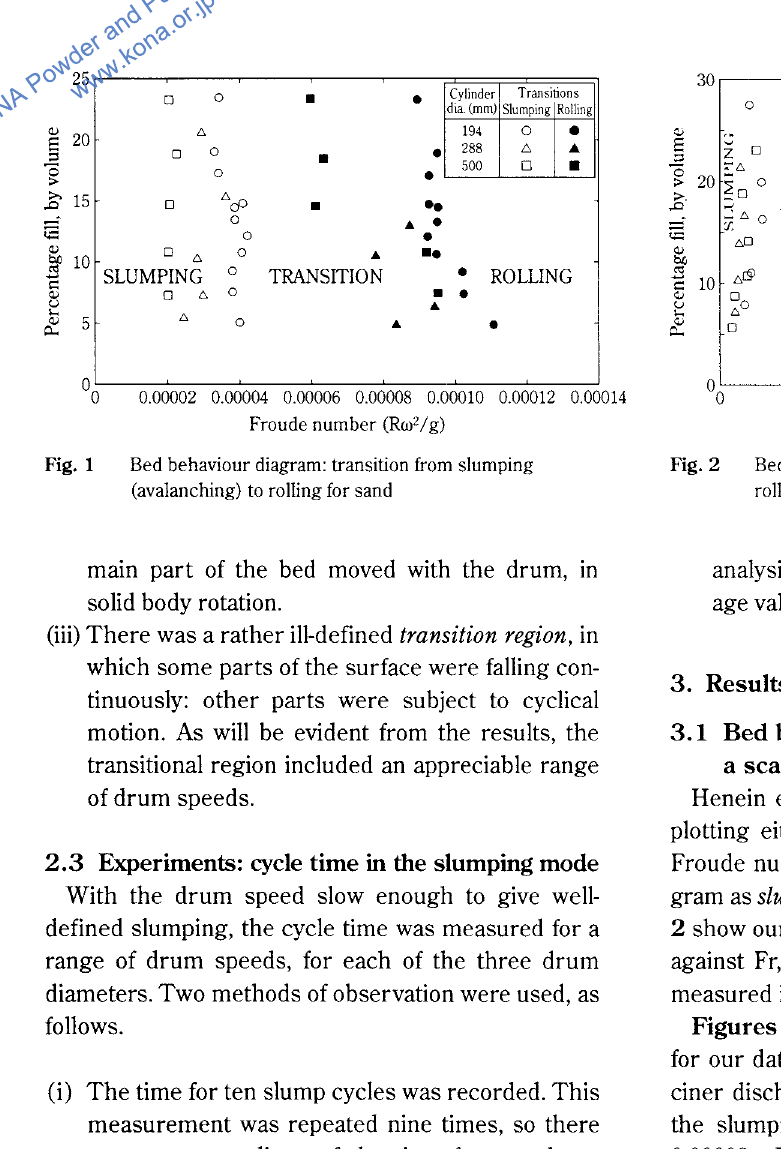
Bed behaviour diagram: transition from slumping (avalanching) to rolling for sand